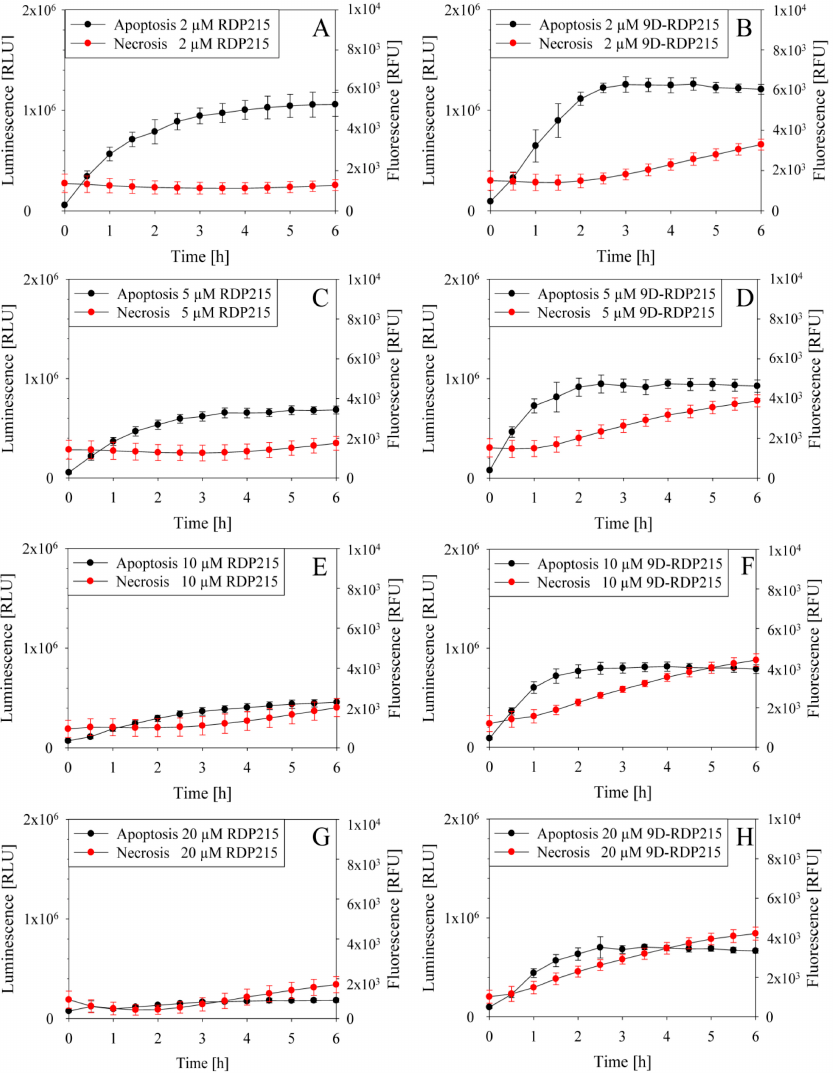
Figure 13. Study of RDP215 and 9D-RDP215-induced cell death in glioblastoma LN-229 by